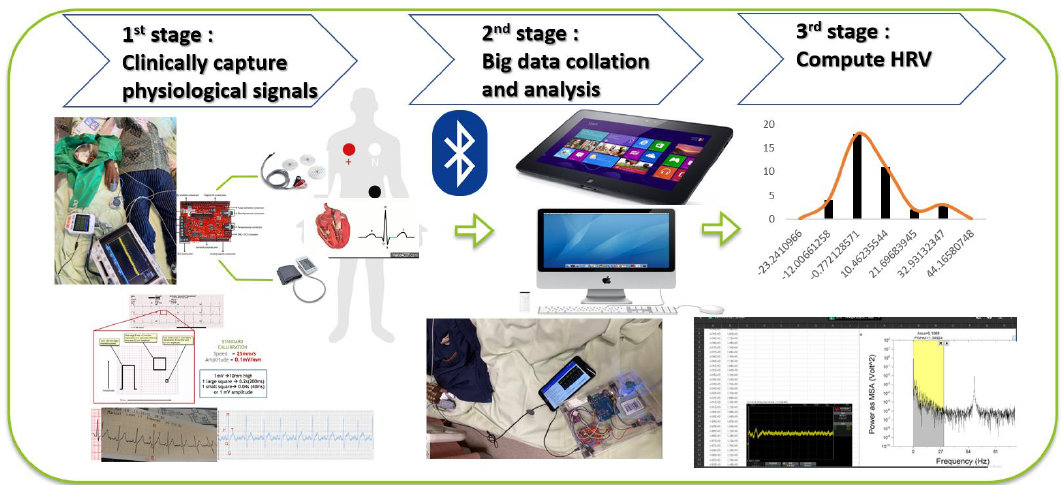
Figure 4. The block diagram of complete methodology.